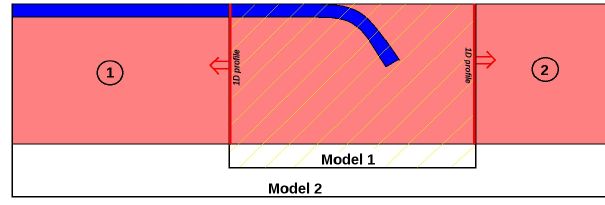
Fig. A2. Schematic representation of the subduction model. See text for the explanation.